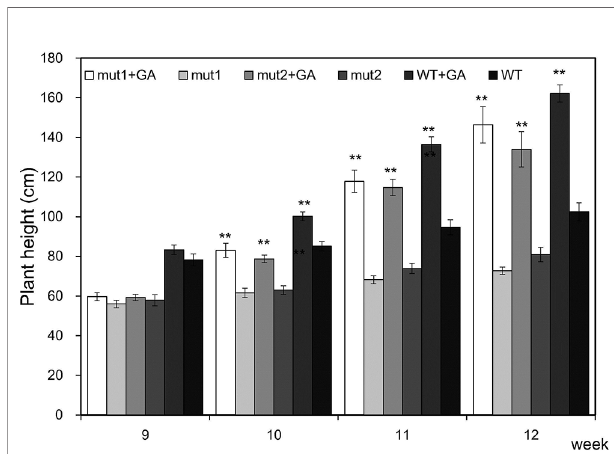
FIGURE 6 | Effect of exogenous GA 3 on the plant height of WT and mutants. Plant heights were measured 9 weeks after emergence. The values presented are the means ± S.E.s of 10 individual plants. ** indicates signi fi cant differences at the P< 0.01 level.